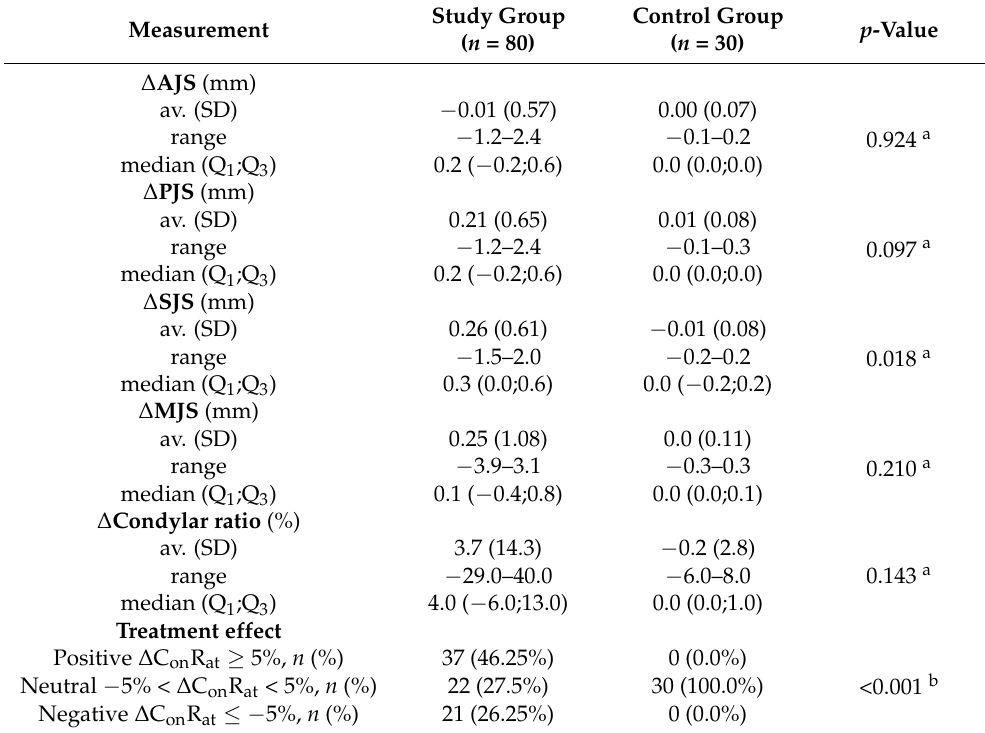
Table 10. Comparison of the average changes in the values of different joint spaces and the average changes in condylar ratio between the examined